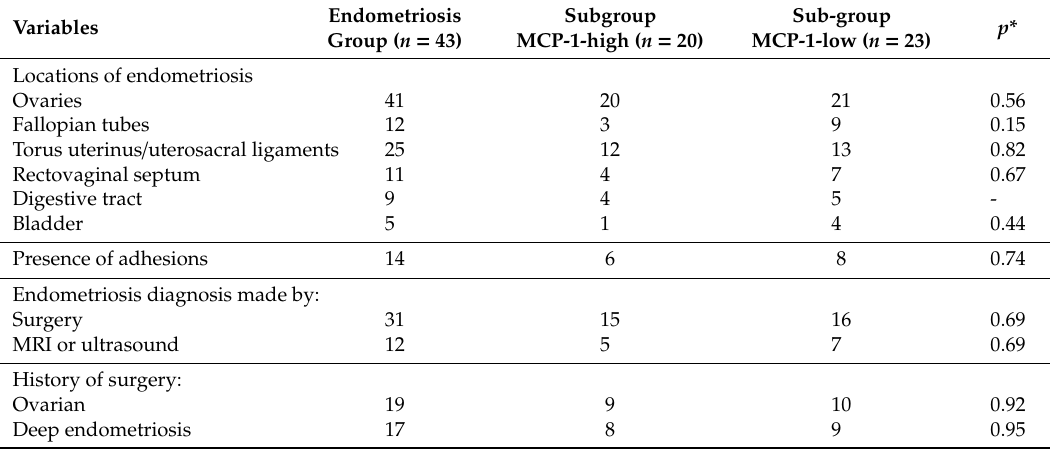
Table 2. Characteristics of endometriosis patients, MCP-1-high, and MCP-1-low subgroups. Variables